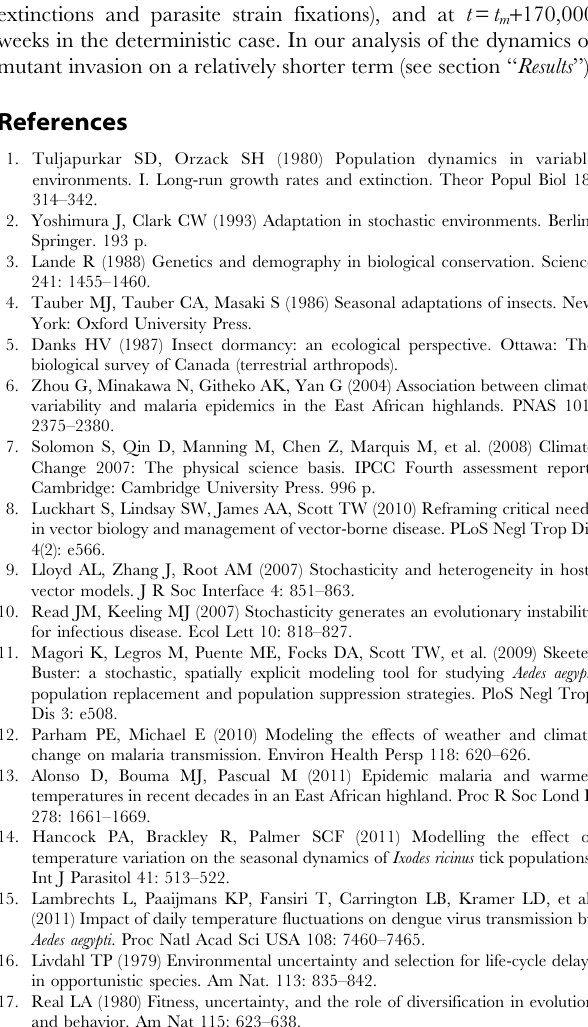
Figure S1 Sequence of events between time t and t + 1 in the one-parasite-strain model. (PDF) Figure S2 Pairwise Invasibility